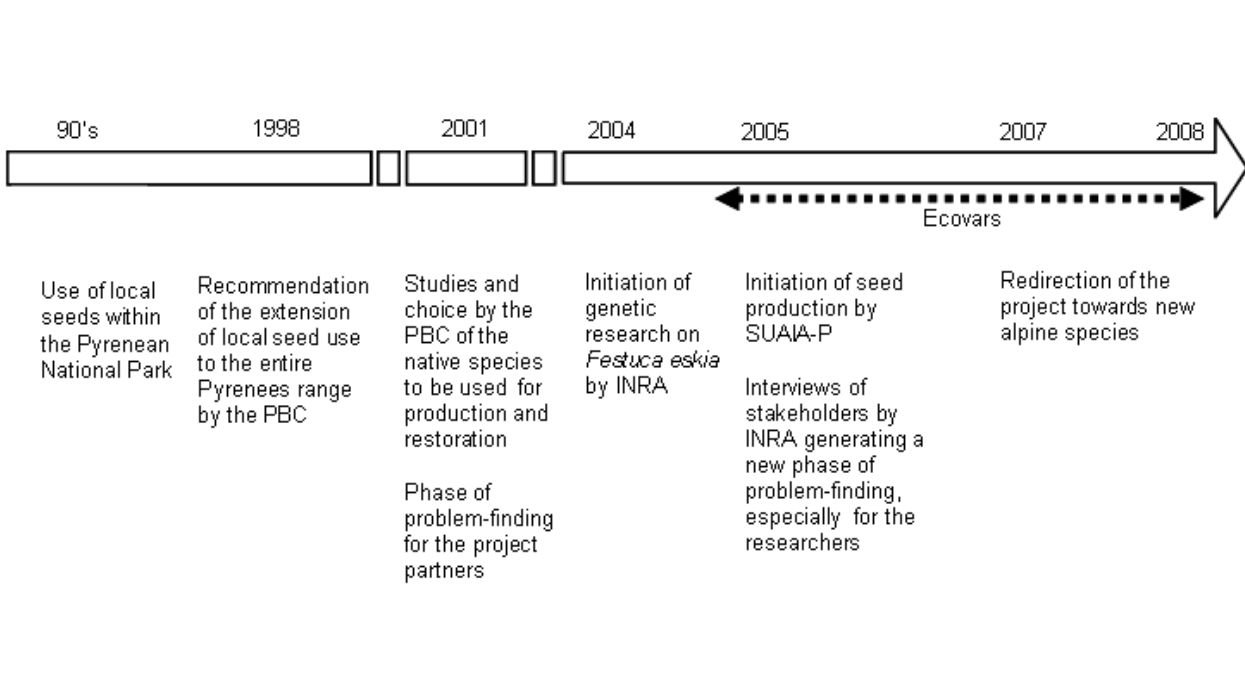
Fig. 2. Chronology of the events before and during the Ecovars